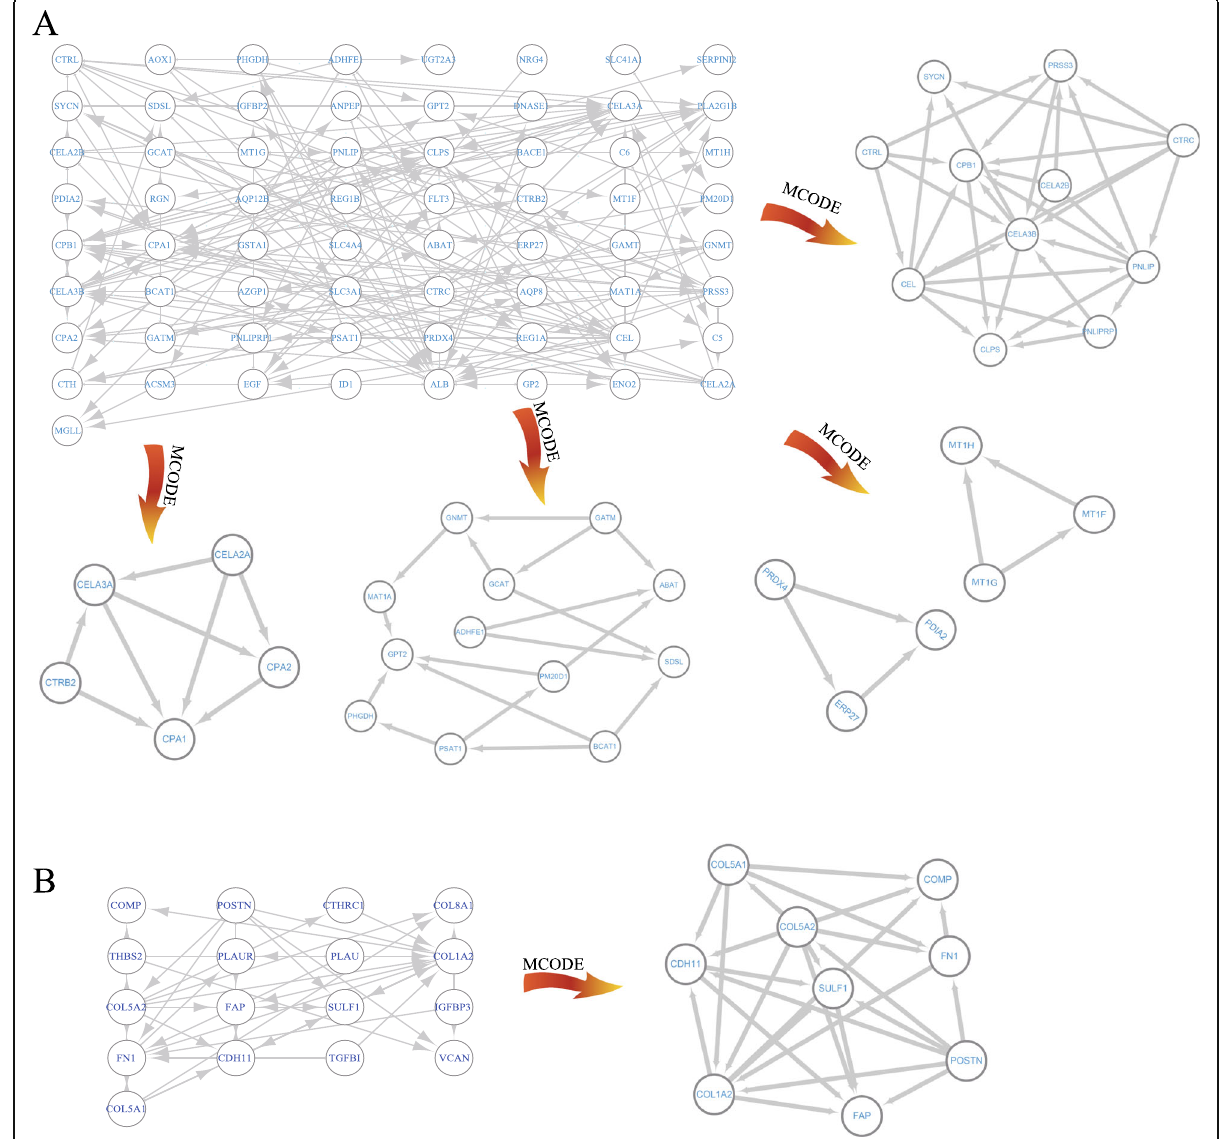
Fig. 4 Visualization and identification of key genes form turquoise and blue module. a Co-expression network of turquoise module and sub-clusters that were highly interconnected regions in the network based on topology. b The co-expression network and sub-clusters of blue